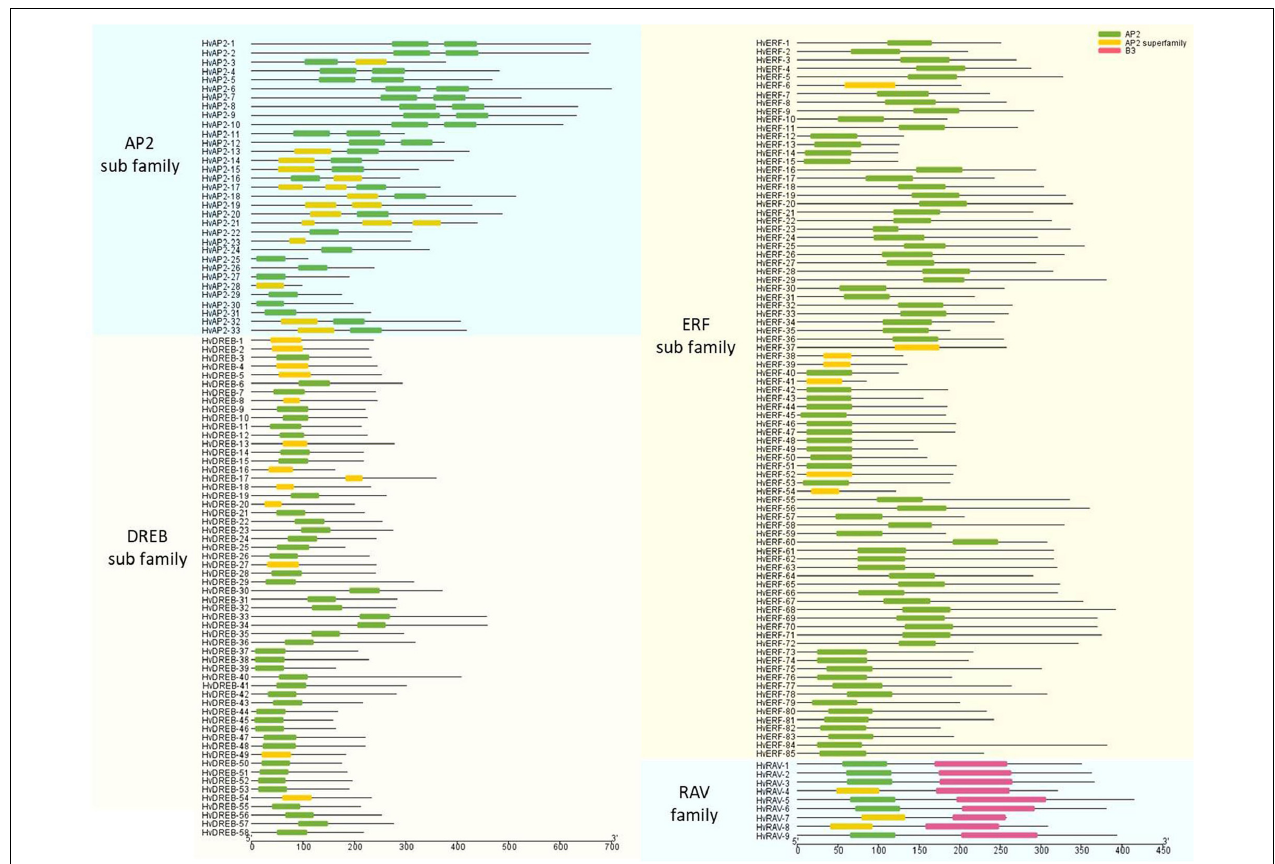
FIGURE 2 | AP2 domains of barley HvAP2/ERF